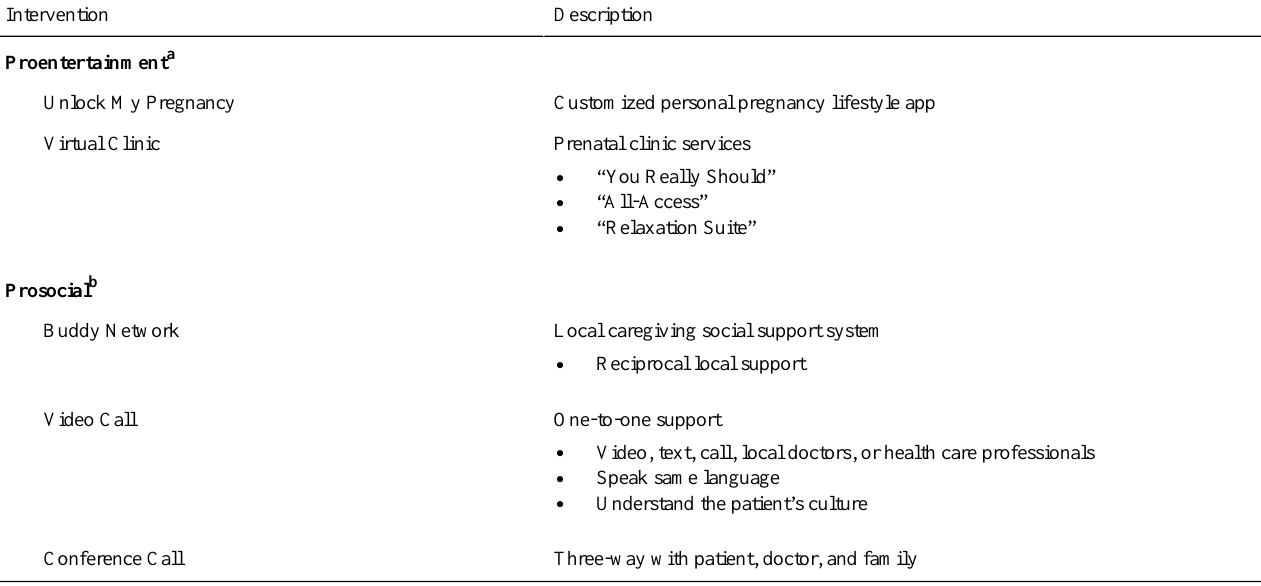
Table 1. Social design interventions relevant to transmigrant